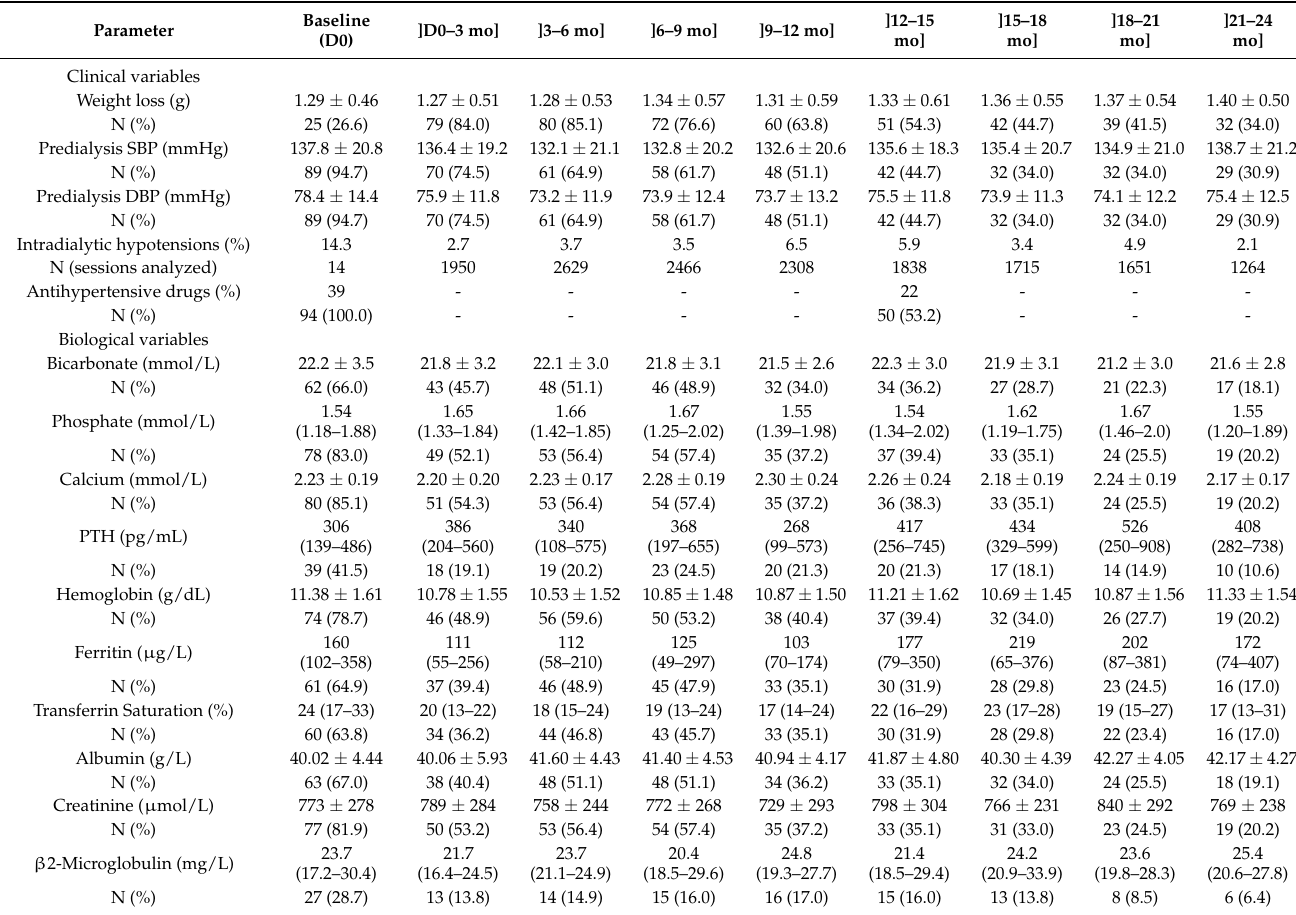
Figure 4. Evolution of plasma phosphate concentrations (median ± IQR). Table 4. Clinical and laboratory